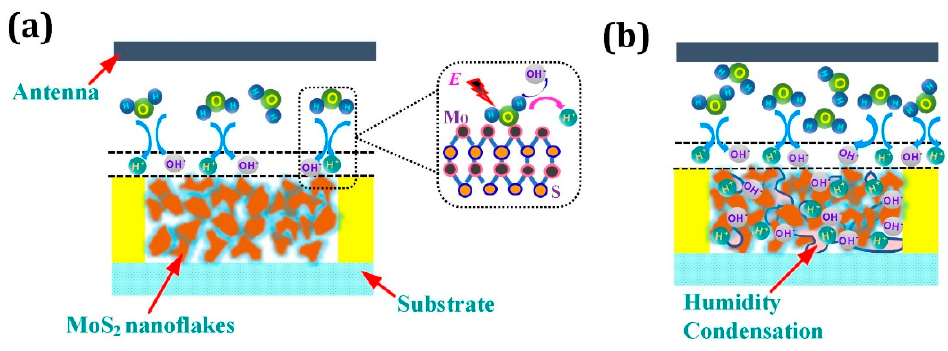
Figure 7. Sensing mechanism ( a ) under low humidity conditions (10–60 %RH) and ( b ) under high humidity conditions (60–95 %RH).